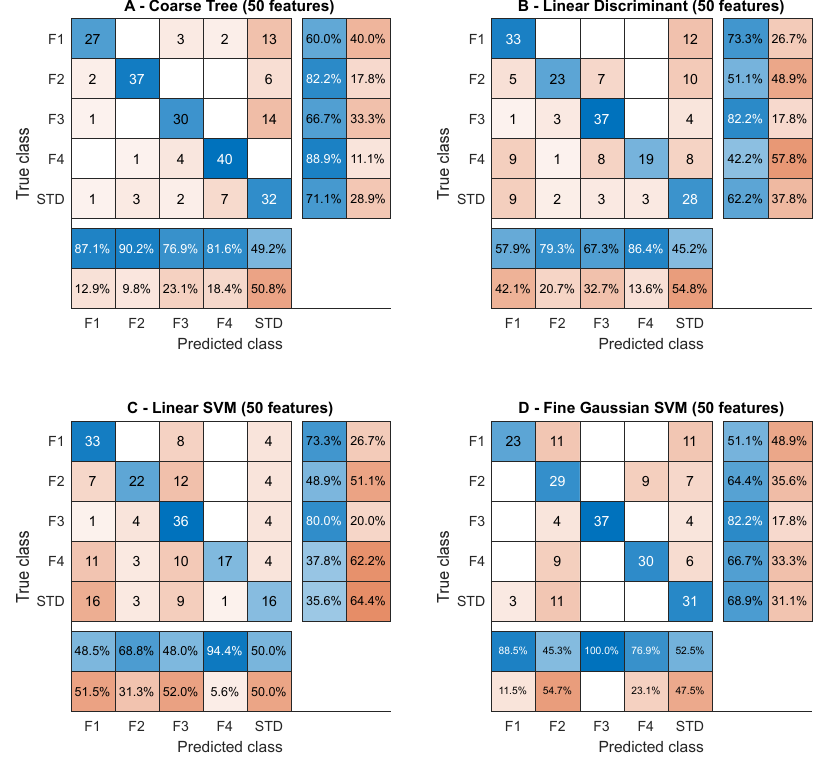
Figure 12. Confusion matrices.